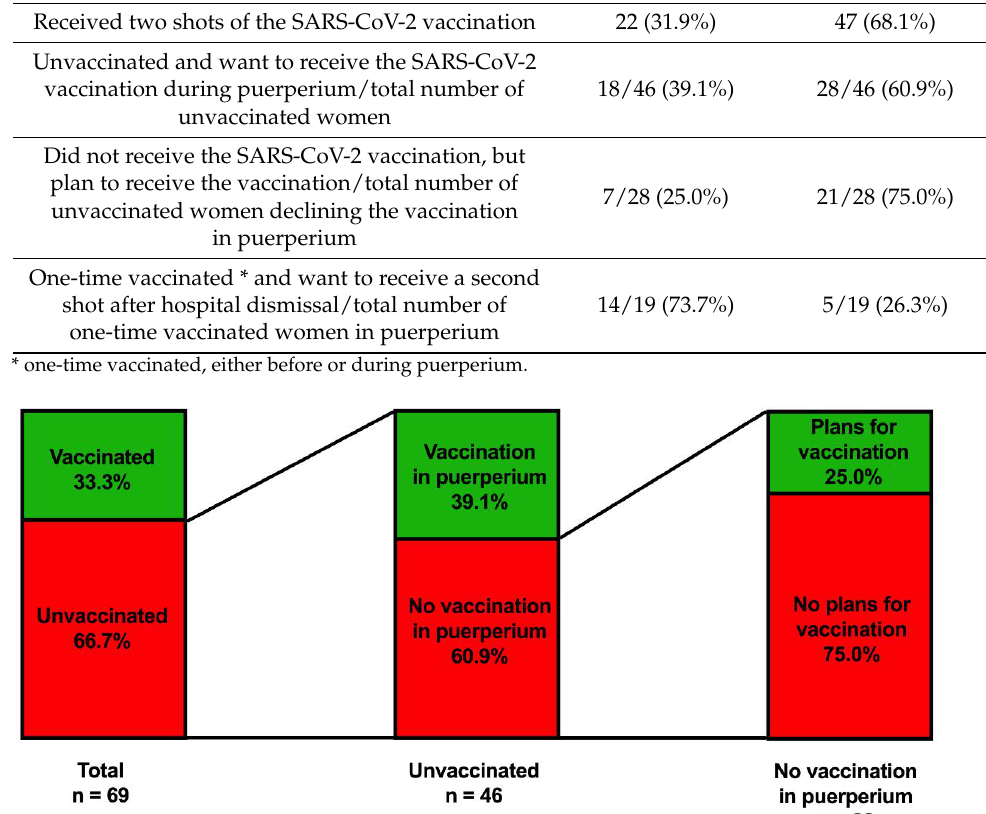
Table 2. Assessment of SARS-CoV-2 vaccination status and willingness to receive the vaccination among 69 women in the evaluation group.